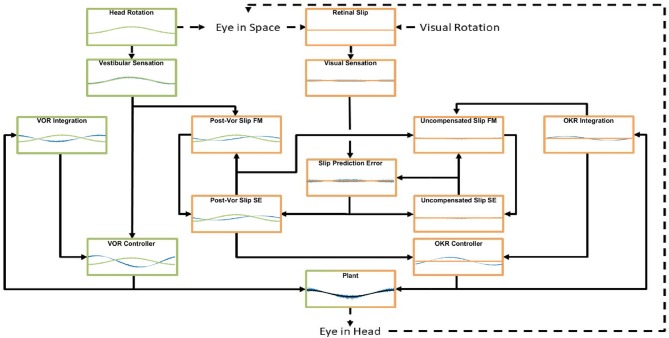
An example of the model dynamics for one cycle of the simulation in the vVOR condition (Stimulation amplitude of 2 degrees at a frequency of 0.2 Hz) at a time by which the system has reached a steady state. The layout matches the model schematic presented in Figure 1, Forward Models are labeled FM and State Estimators are labeled SE. In each box the blue line represents the output of the computation performed, the green or orange line represents the appropriate stimulus, vestibular and visual, respectively. In the supplement, we display the full model dynamics for the VOR and OKR conditions in isolation, respectively, for the same frequency and amplitude of stimulation.